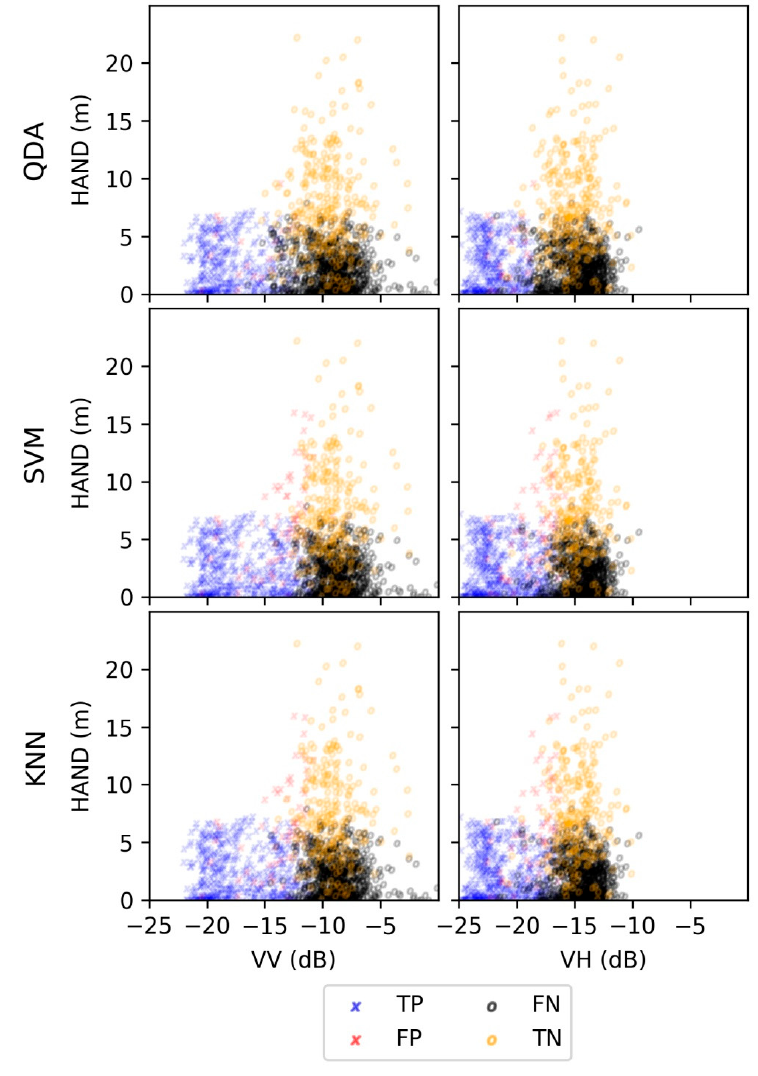
Figure 9. Primary metrics for all three classifiers on Goldsboro illustrated as scatter points for HAND vs. VV and HAND vs. VH for the feature set that did not include HAND. Demonstrates the decision boundaries generated by the classifiers and the relationship between SAR backscatter and HAND. Points are a random sample of overall study area ( ≤ 0.2%).